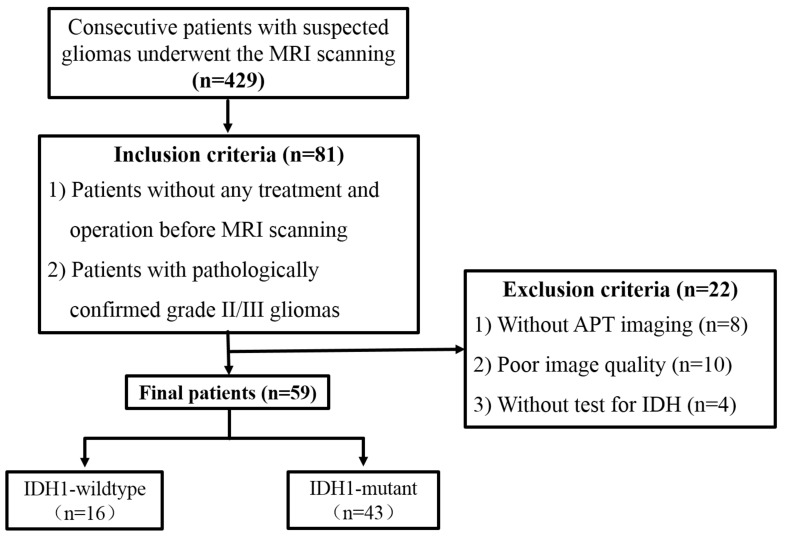
Flow diagram for patient selection.